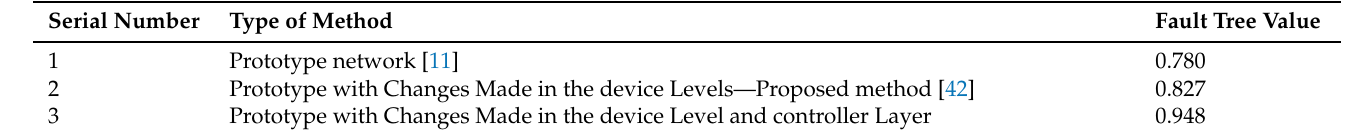
Table 6. Comparative analysis of enhancements for fault tolerance in different layers of the IoT network.